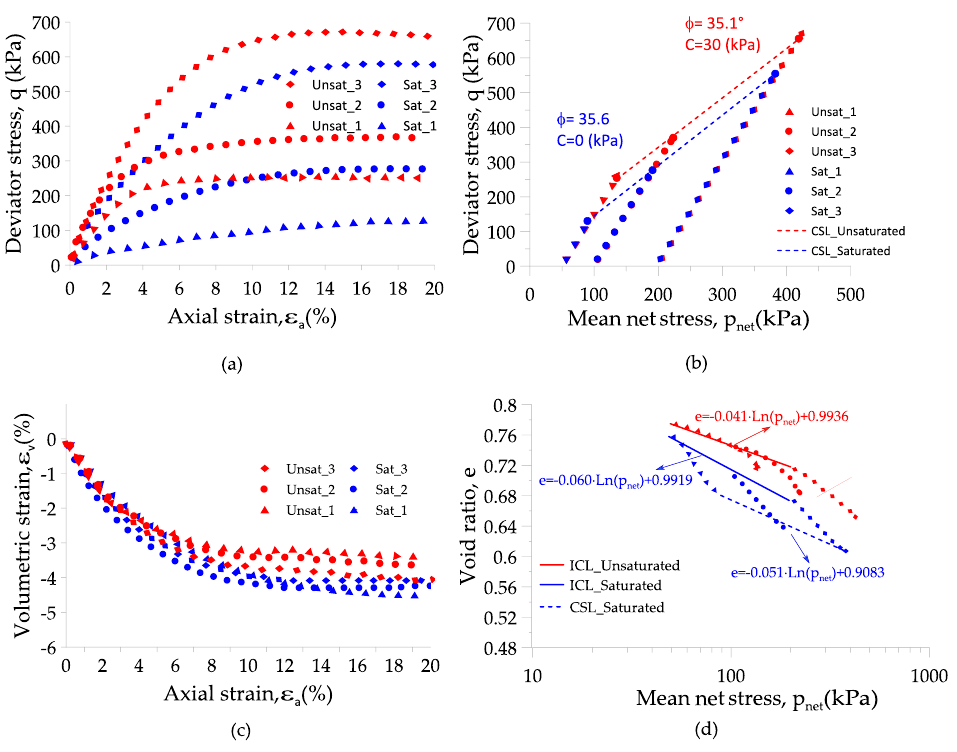
Figure 13. Behavior of the soil studied at a dry unit weight of 16.5 kN/m 3 . ( a ) Diagram of stress relative to axial strain (q vs. ε a ). ( b ) Diagram of p net vs. q. ( c ) Volumetric strain versus axial strain. ( d ) Diagram of p net vs. void ratio during the shear phase.